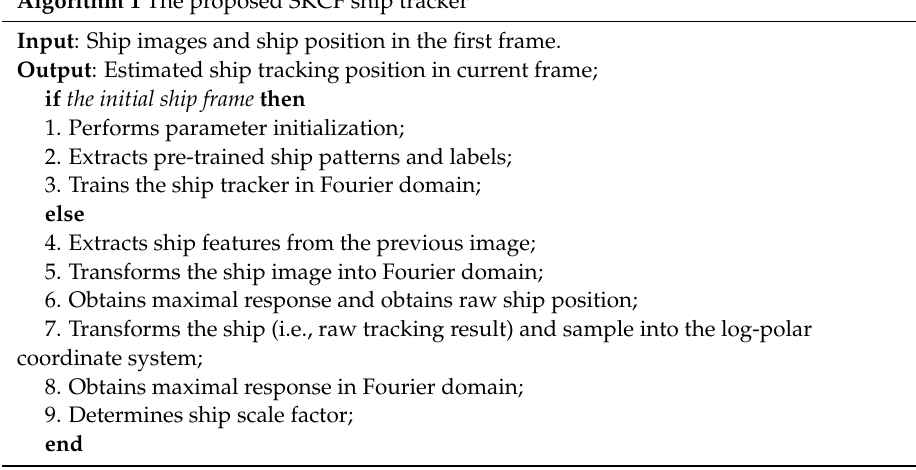
Algorithm 1 The proposed SKCF ship